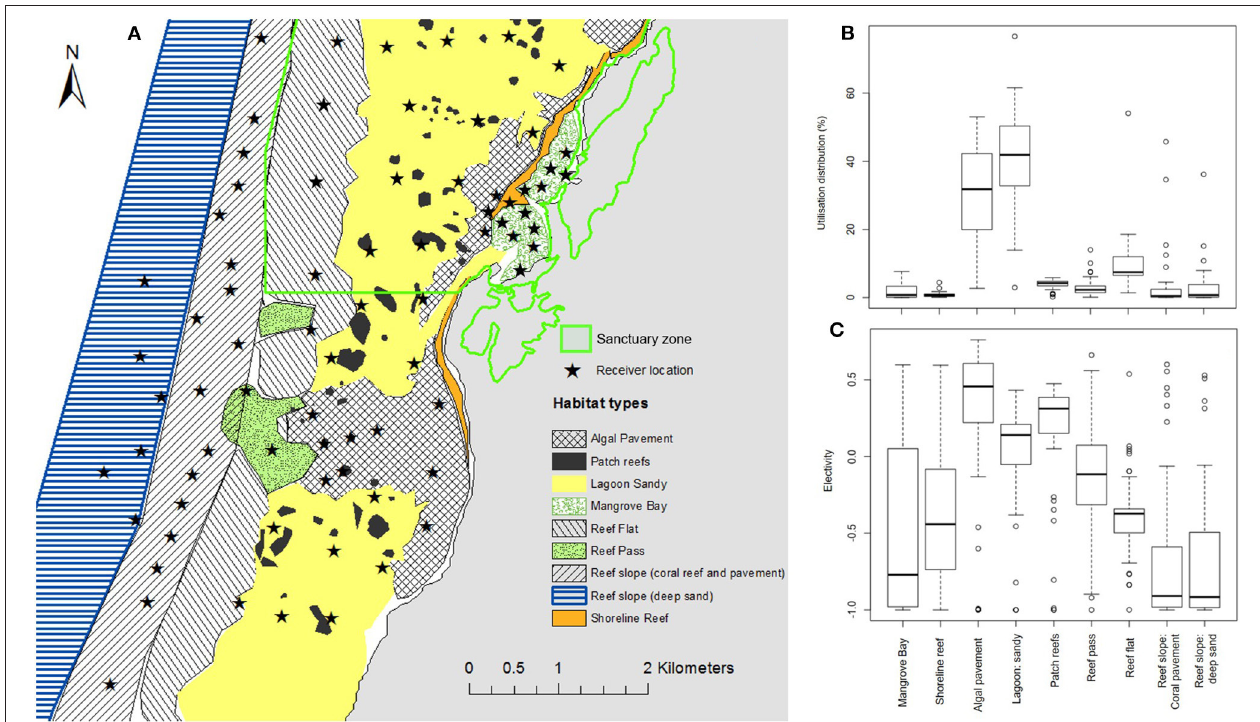
FIGURE 8 | (A) Map of the Mangrove Bay array showing sanctuary zone boundary, receiver locations, and habitat polygons used to estimate electivity. (B) Box and whisker plot of the percentage of utilization distribution in each habitat type, (C) box and whisker plot of Ivlev’s electivity index for each habitat. Individual electivity values from all individuals were sufficient data were available ( n = 31) were used. Values above zero indicate increasing selection of that habitat, values of zero indicate neither avoidance or selection and values below zero indicate increasing avoidance of that